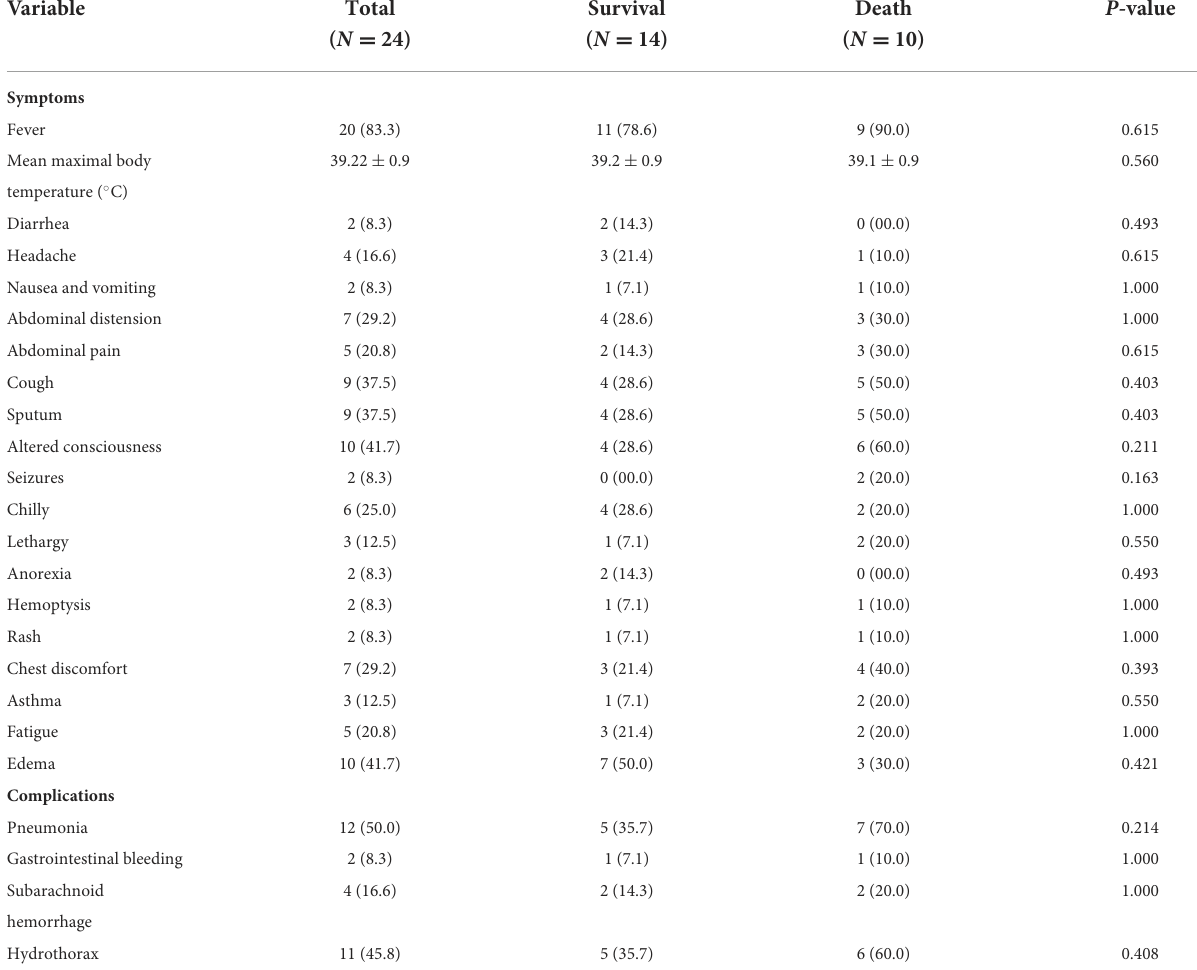
TABLE 2 Clinical symptoms and complications analysis of patients infected with E. meningoseptica ( N = 24).